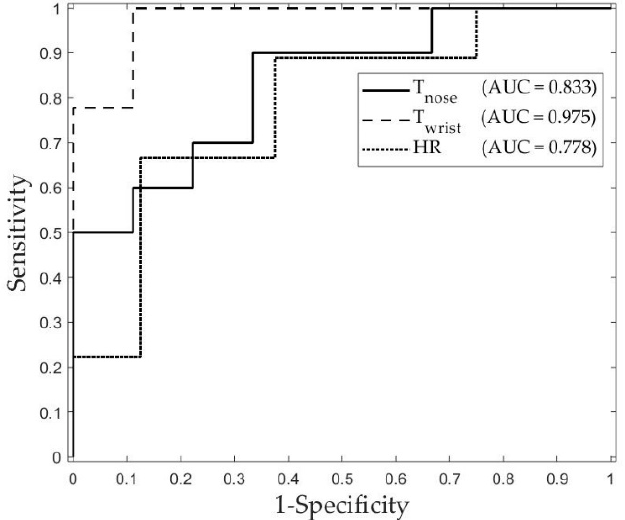
Figure 5. Receiver operating characteristic (ROC) curve and corresponding area under the curve (AUC) for the univariate classification based on T nose , T wrist , and HR. Table 2. Performance of the different classifications based on information about T nose , T wrist , and HR. The “strict” multivariate classification refers to the fact that for all three variables, the imposed constraints must hold for a driver to be classified as drowsy. The “mild” classification represents the case when a driver is labeled as drowsy when only two out of three constraints are met. The sensitivity, specificity, and accuracy are expressed as a percentage. N drowsy and N non-drowsy indicate the number of samples used in each case.